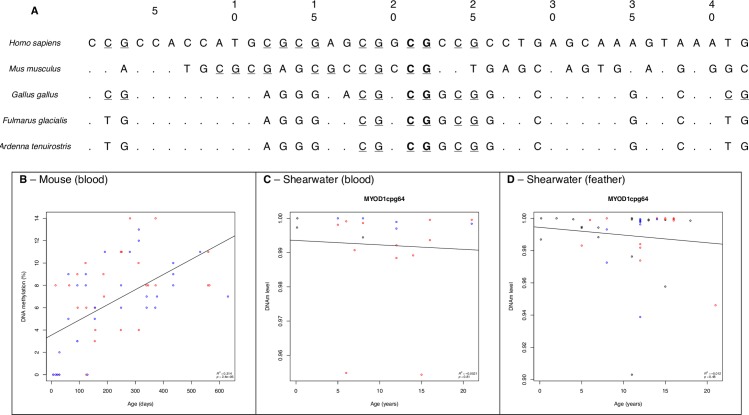
MYOD1 sequence conservation in mammals and select birds.A: 20 base pairs are shown for both directions around an age related CpG loci (cg18555440, in bold) in the MYOD1 gene in humans. Following the methods described in text, this sequence was compared to the mouse, chicken and northern fulmar genomes. Conserved bases are shown with a dot (.) and the base is given where there is a mismatch. Other CpG sites in the sequence are underlined and are shown for bird sequences. In this example, 4 CpG loci in humans were conserved in chicken, 2 were lost (pos. 12 and 14) and 1 was gained (pos. 41). However in fulmar and shearwater, 3 CpG loci were conserved whilst the remaining 3 in humans were lost (pos. 2, 12 and 14). Primers were designed from the fulmar sequence to amplify isolated shearwater DNA; for this short sequence there was 100% conservation between the two animals. A plot of the age relationship observed in mice at cg18555440 (Spiers et al. 2016) Fig 2B. The DNAm results for the same CpG site in shearwater are shown for shearwater blood, Fig 2C and shearwater feather, Fig 2D. Males and females are shown in red and blue respectively.